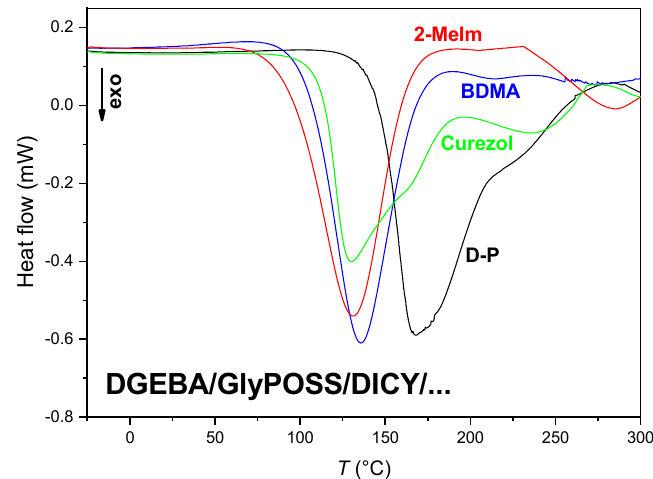
Figure 3. Normalized differential scanning calorimetry (DSC) curves of the D-P-based formulations. Table 1. Thermal properties of D-P-based formulations used for the preparation of coatings. Sample T onset 1